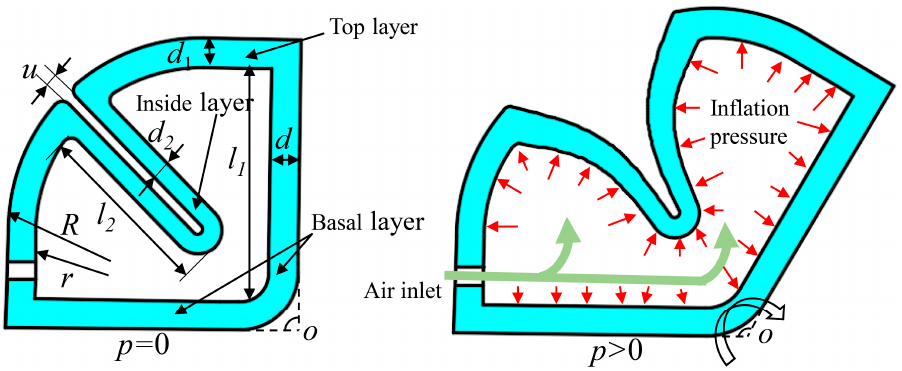
Figure 2. Double ‐ constrained balloon